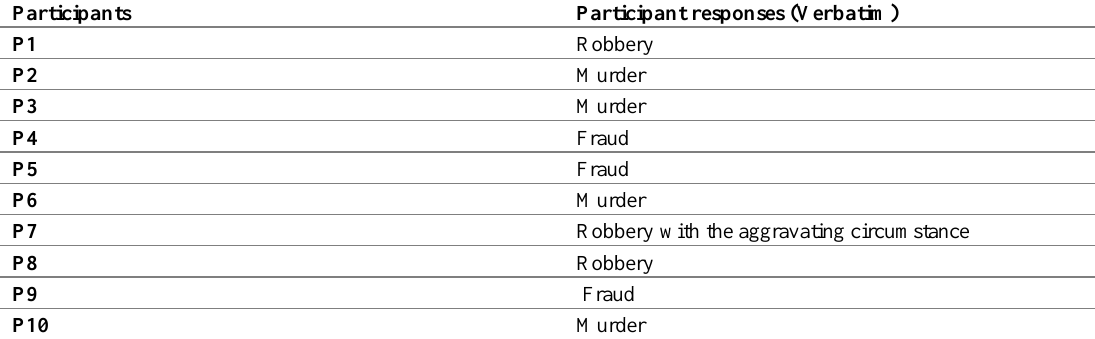
Table 3: Type of crime committed and reasons